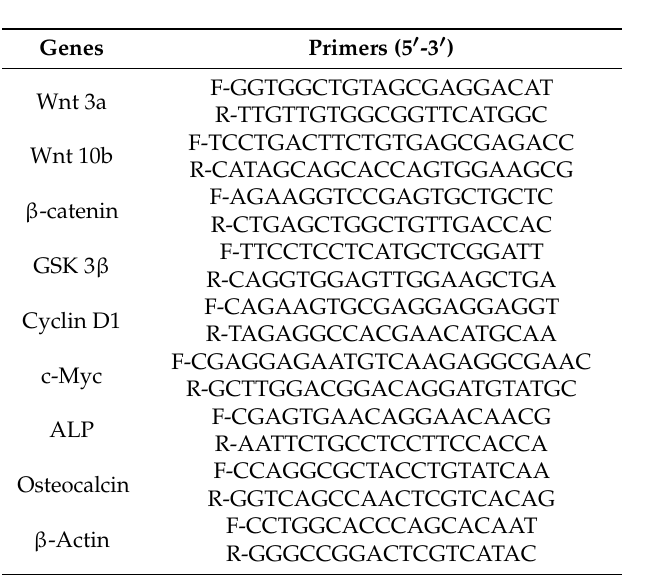
Table 4. The primers used in real-time RT-PCR